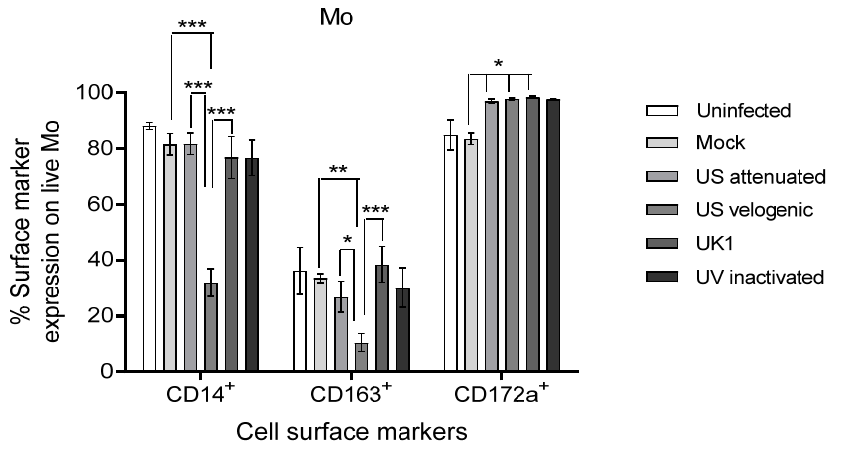
Figure 5. Phenotypic changes induced by EAV on live Mo. Monocytes were inoculated at MOI of 5 with different strains of live or UV inactivated EAV. Controls were uninfected (media only) and mock infected cells. Cultures were incubated at 37 °C in 5% CO 2 for 16 h. Cells were stained with the live/dead fixable near-IR dead cell kit, followed by staining with anti-CD14-FITC, anti-CD163- Vioblue and anti-CD172-PE. Stained cells of the different treatments were assessed by comparing the same number of events (10,000) in the live cell target gate. The Velogenic strain significantly decreased the expression of CD14 and CD163 on Mo. There were no significant differences in the expression of CD172a; however, it was upregulated by all virus strains and the UV inactivated virus. Results were represented as the % surface marker expression ± SEM ( n = 9). A 2-way ANOVA with Bonferroni post-test was used to compare replicate means. *, ** and *** indicate significant differences between sample means where p < 0.05, p < 0.01 and p < 0.001,